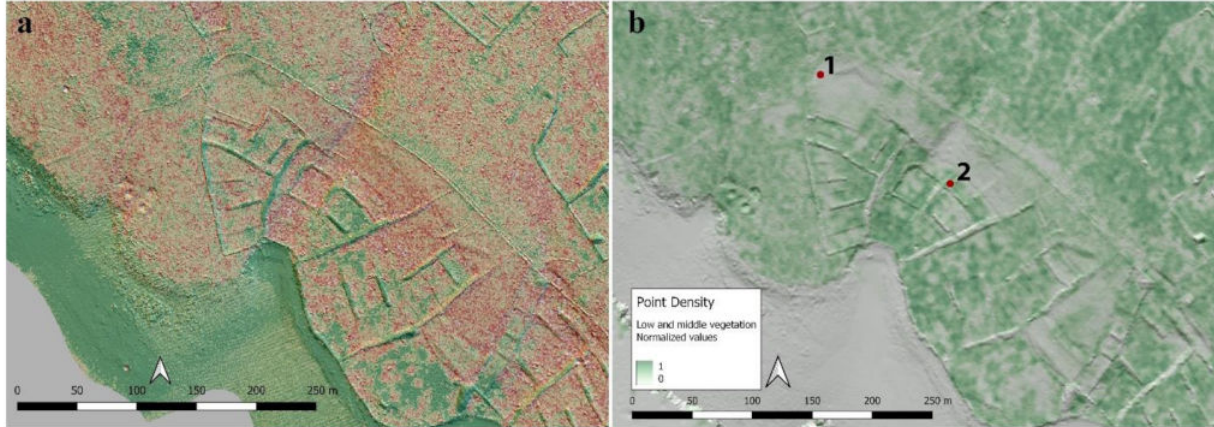
Figure 6. ( a ) Map showing the density of ground points after ground point filtering using the “stone wall” setting. Red colours indicate densely vegetated areas with low penetration rates. ( b ) A point density map of low and medium height vegetation (0–1 m) provides a good estimate of accessibility for ground observation. The red dots show the locations of ground photographs. Nr. 1: Figure 18, Nr. 2: Figure 16E.